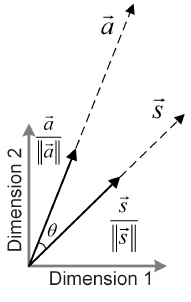
Figure 9. Schematic diagram of the cosine distance with two dimensions.